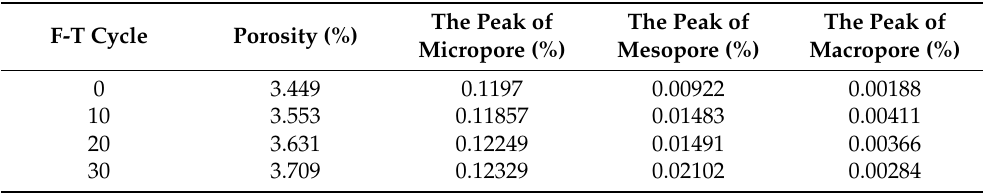
Table 4. The test results of microscopic pores under different freezing-thawing cycles. F-T Cycle Porosity (%)